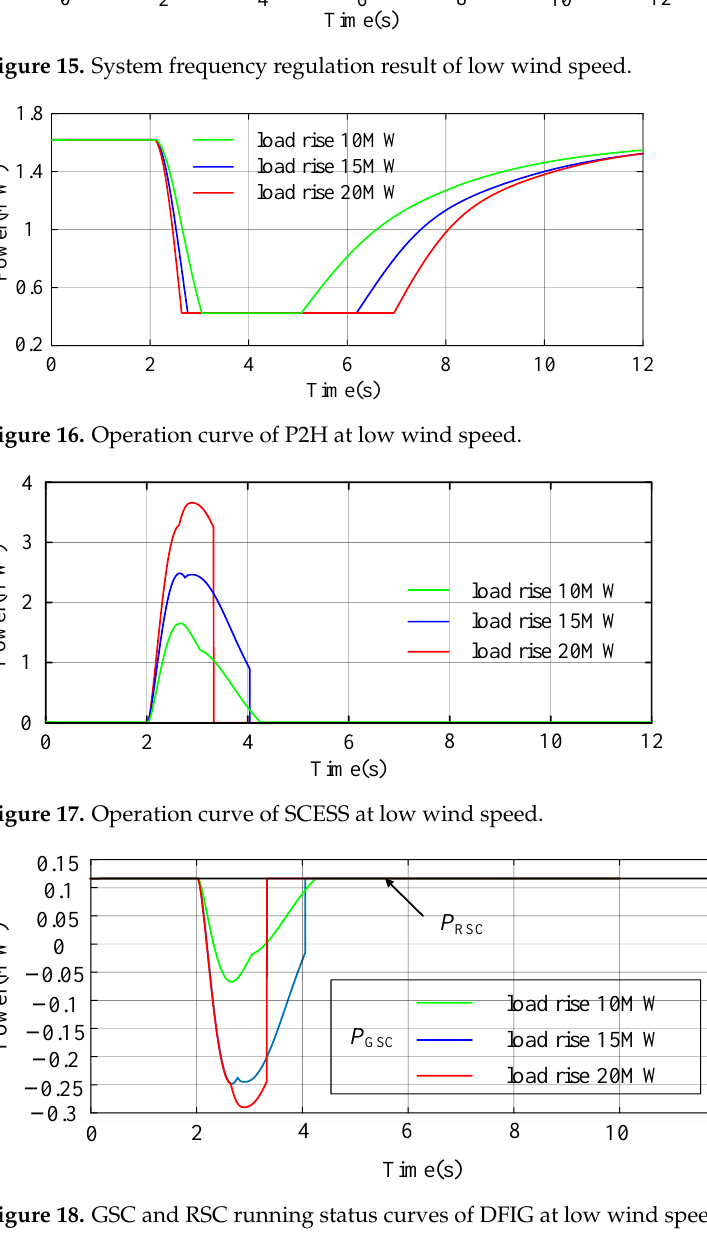
Figure 18. GSC and RSC running status curves of DFIG at low wind speed.